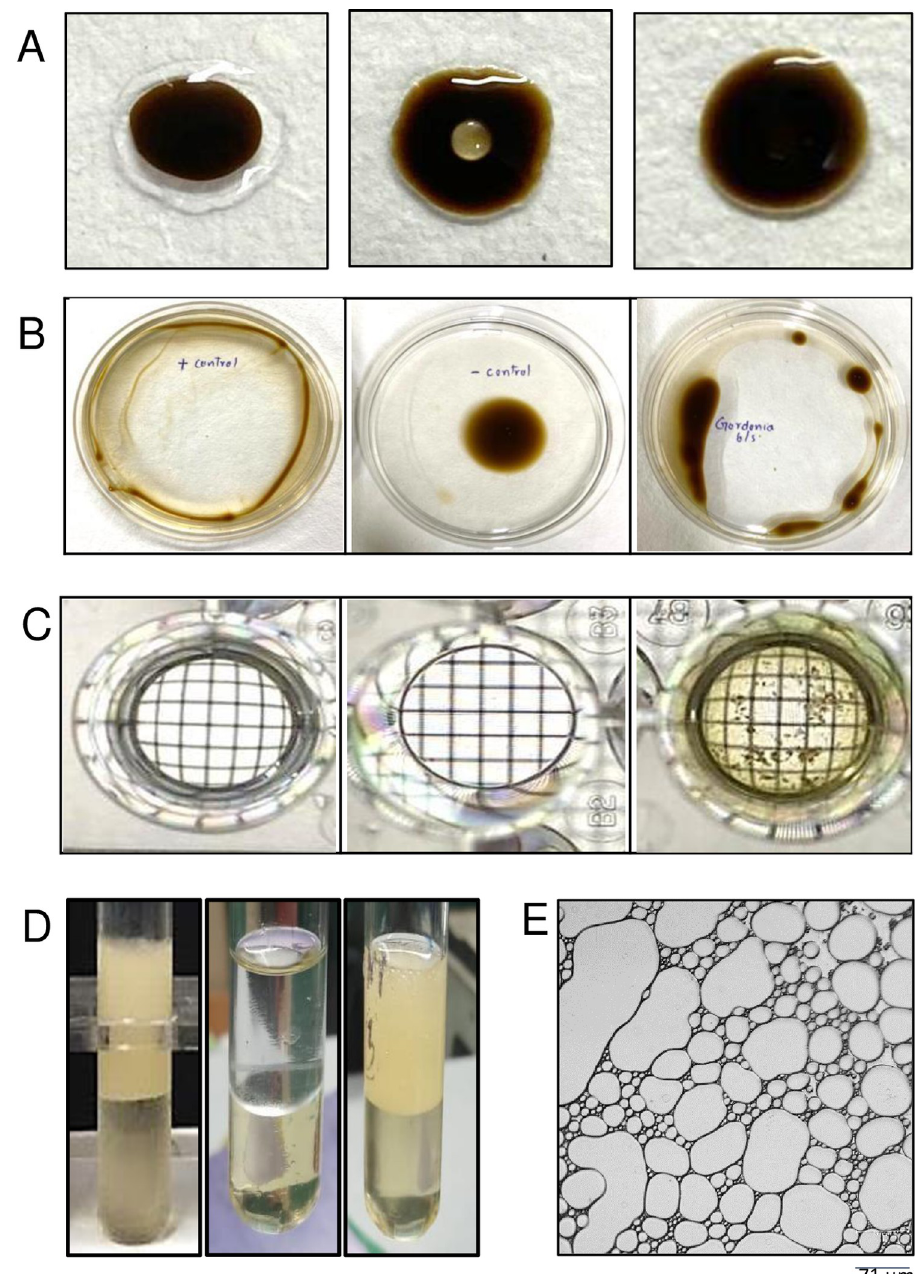
Fig 1. Biosurfactant screening assays: A. Drop collapse assay on glass slide, B. Oil spreading assay, C. Microplate assay, D. Emulsion index assay, E. Microscopic image of the emulsion formed by cell free supernatant of Gordonia sp. IITR100. (Left panel) 10% SDS (Middle panel) water, and (Right panel) cell free extract of Gordonia sp. IITR100.